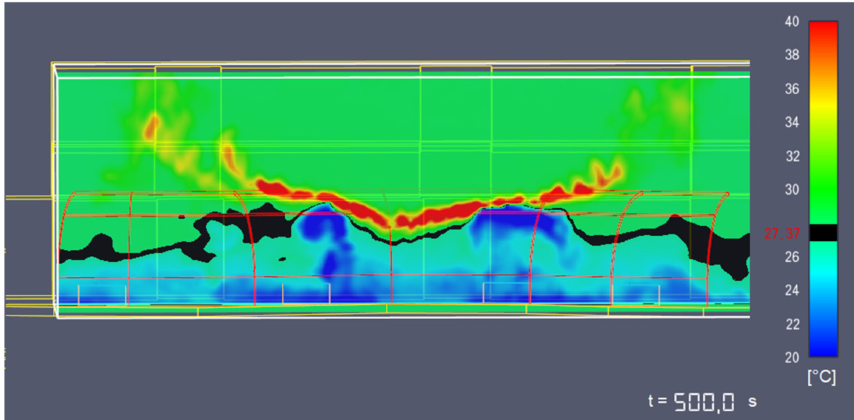
Figure 13. Reference configuration: air temperature distribution in the section x = 3.1 away from the wall, t = 500 s.